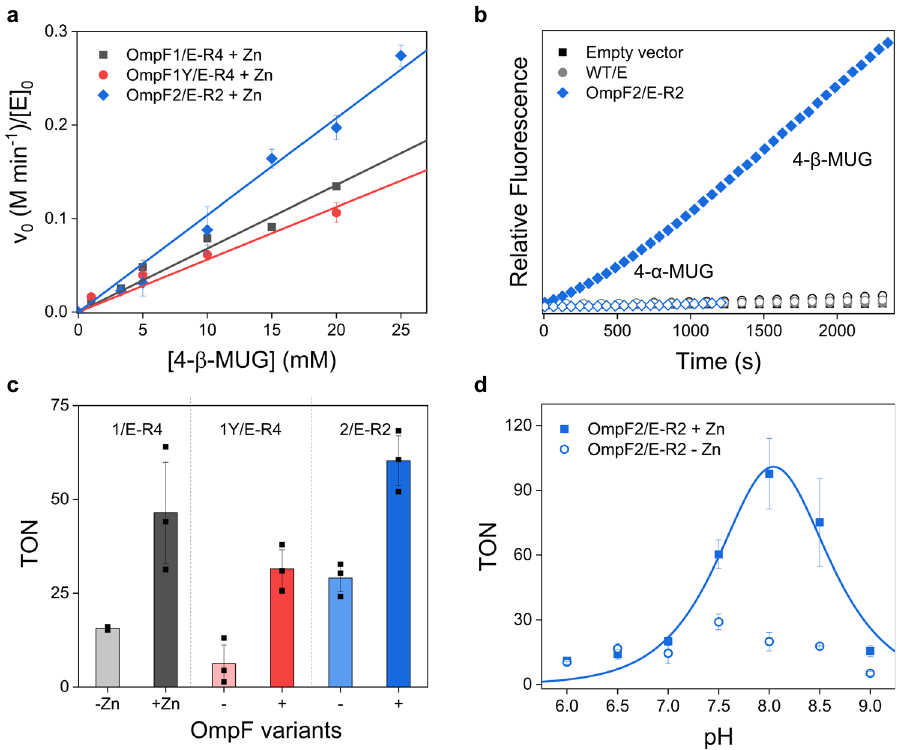
Fig.4|GlucosidaseactivitiesofOmpFvariantswith4- β -MUG.a Kineticanalysis. b Whole-cell activities of OmpF2/E-R2. c Turnover number (TON) in the absence and presence of Zn ions. d The pH-dependent activities of OmpF2/E-R2. The data